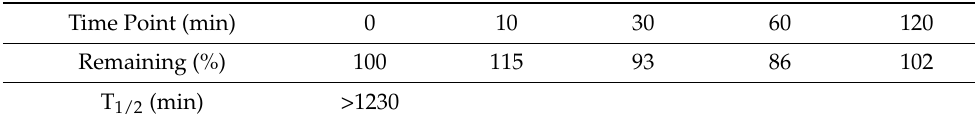
Table 7. Plasma stability of compound 10a .